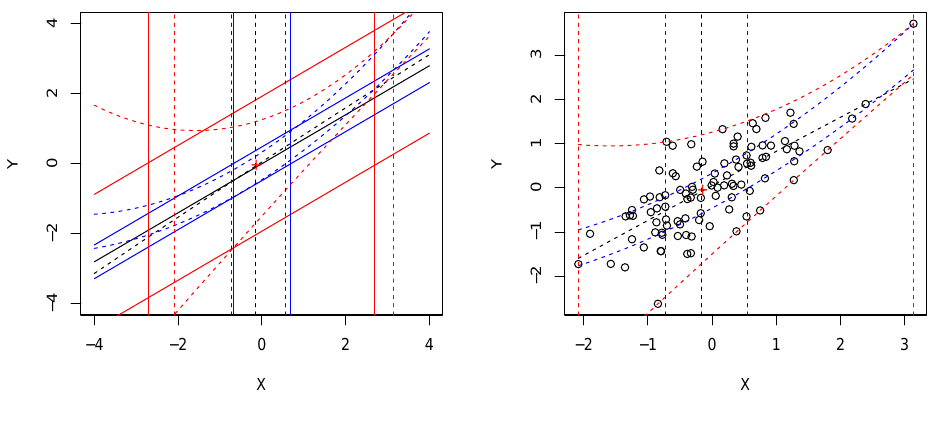
Figure 9: Quadratic empirical BBP (dashed lines) in option 1. b for the data in Example 2.1. The continuous lines represent the theoretical BBP.